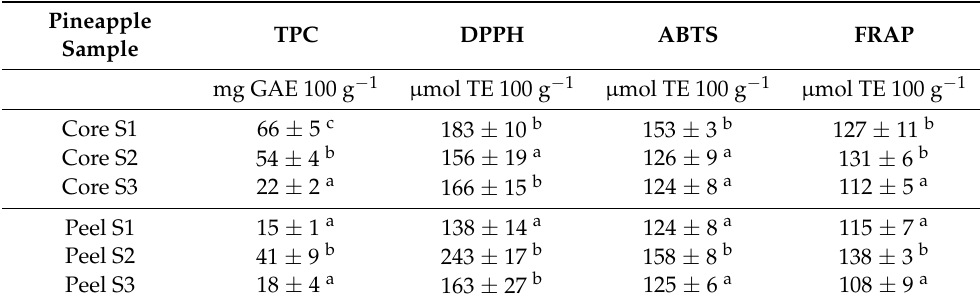
Table 2. Total phenol content and DPPH, ABTS, and FRAP antioxidant capacity values obtained for the pineapple core and peel of three